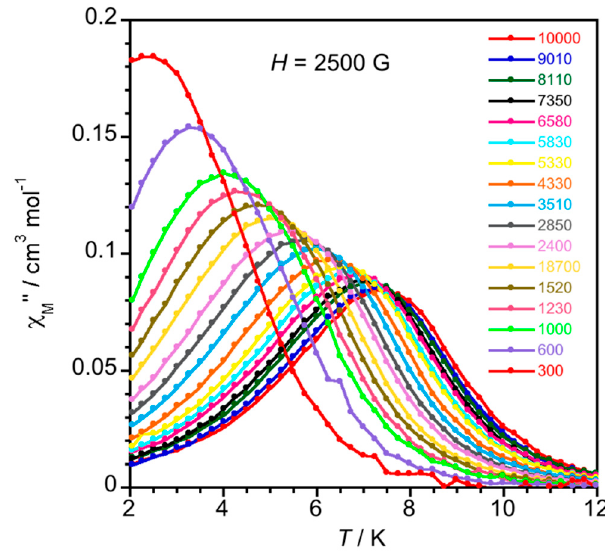
Figure 6. Thermal dependence of χ M ” (bottom) for 1 under an applied static field of H dc = 2500 G with a ±5 G oscillating field at frequencies in the range 0.30-10 kHz.